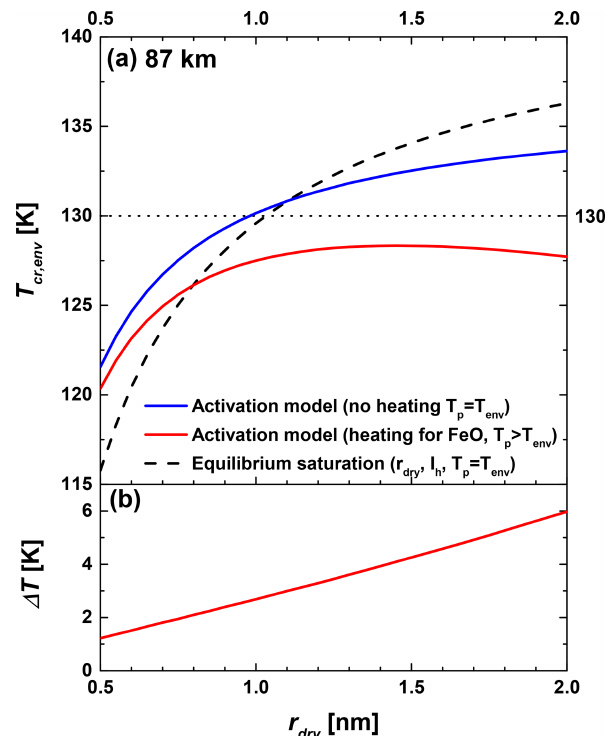
Figure 5. Critical temperature (a) and particle temperature off- set (b) at 87km in altitude for FeO particles as a function of dry particle radius. The blue curve represents critical temperatures cal- culated with the activation model neglecting solar irradiation, and the red curves consider solar irradiation. For comparison, we show the equilibrium saturation calculated using the Kelvin equation for hexagonal ice with the dry particle radius represented by the dashed black